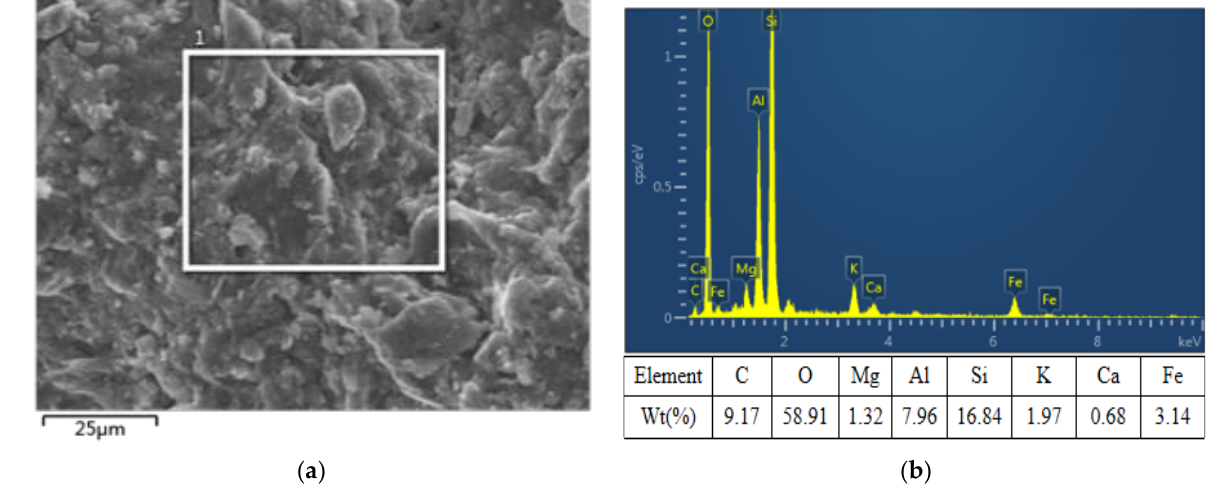
Figure 3. SEM-EDS analysis of a soil specimen: ( a ) SEM and ( b ) EDS.